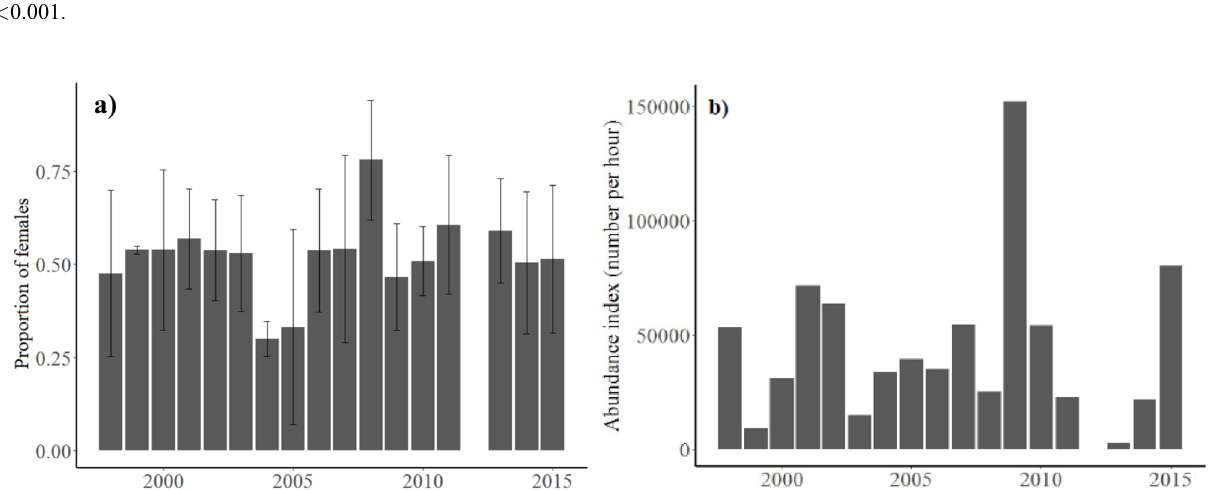
Fig. 4. The average of (a) proportion of females (mean±SD) and (b) abundance index (mean number of individuals caught per hour) by year for blue whiting on the Portuguese